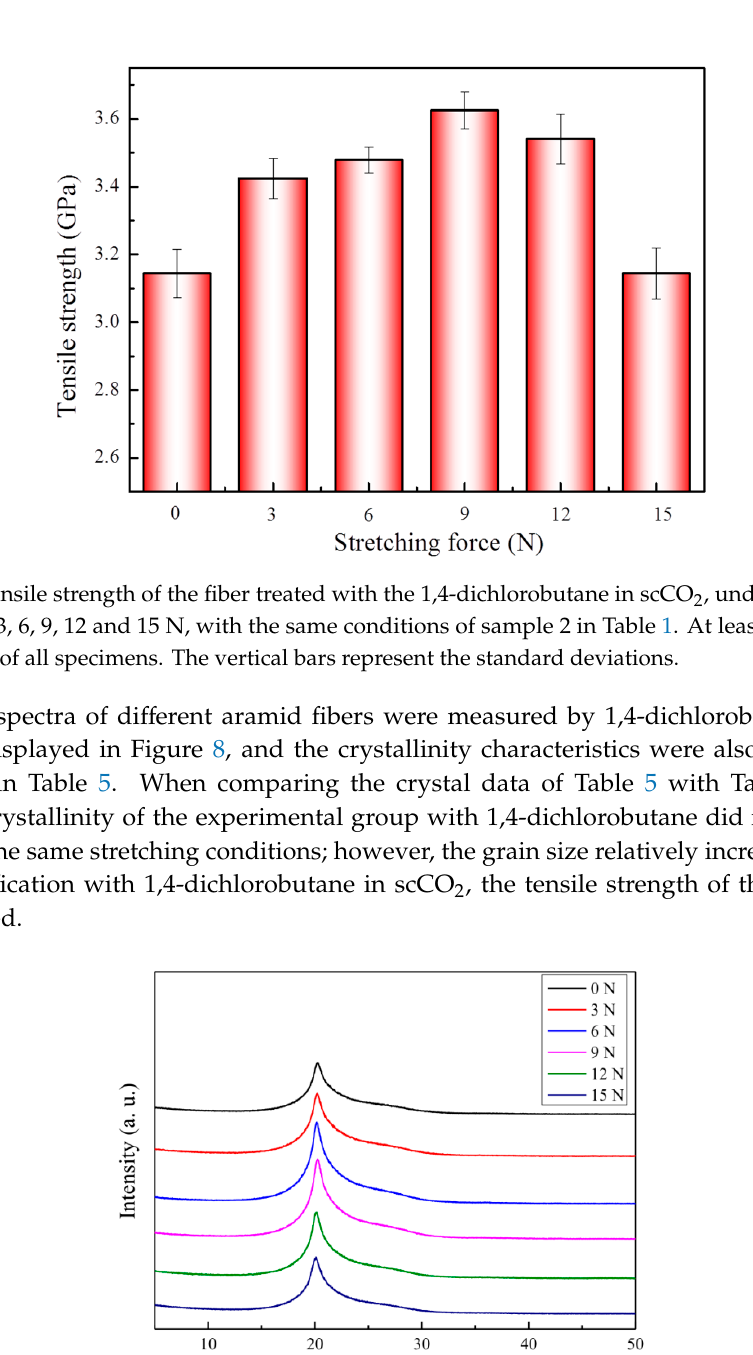
stretching forces of 0, 3, 6, 9, 12 and 15 N, with the same conditions of sample 2 in Table 1.